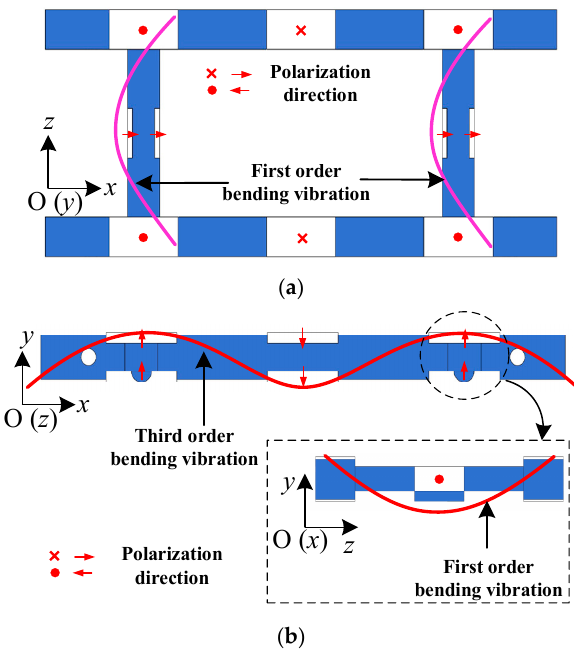
Figure 2. Operating principle of the proposed framed piezoelectric actuator. ( a ) Mode A: the first order bending vibration along the x -direction excited in the two short piezoelectric composite beams. ( b ) Mode B: the first order bending vibration along the y -direction stimulated in the short piezoelectric composite beams while the third order bending vibration along the y -direction excited in the long piezoelectric composite beams.